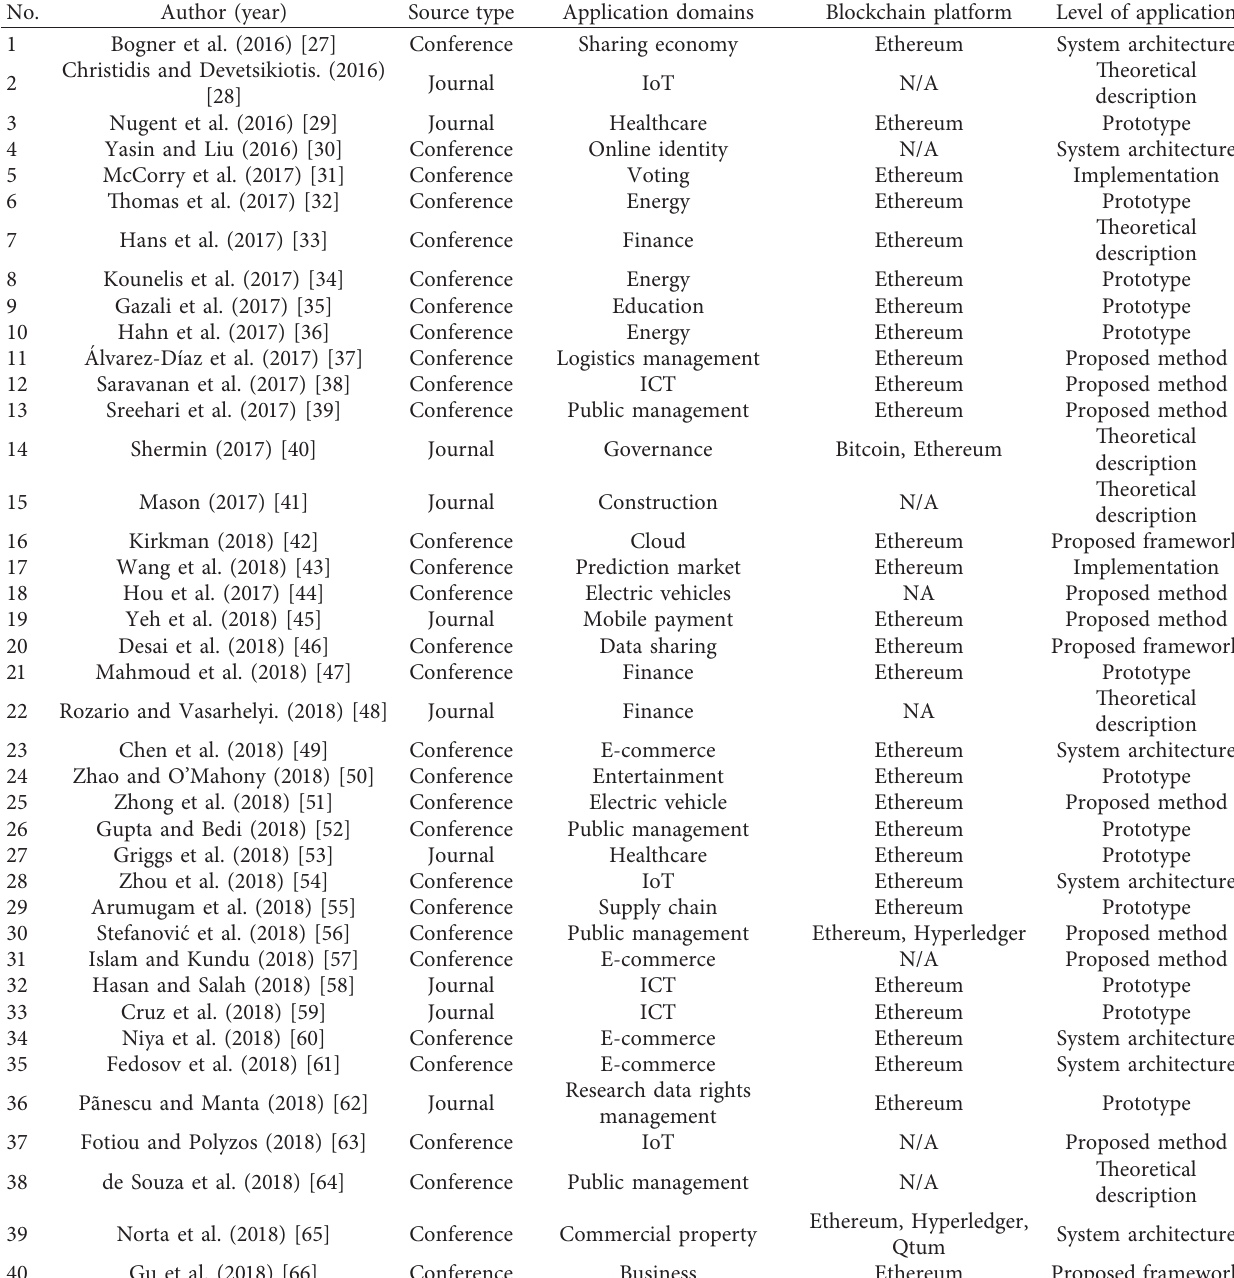
Table 2: Research papers included in the systematic review and their